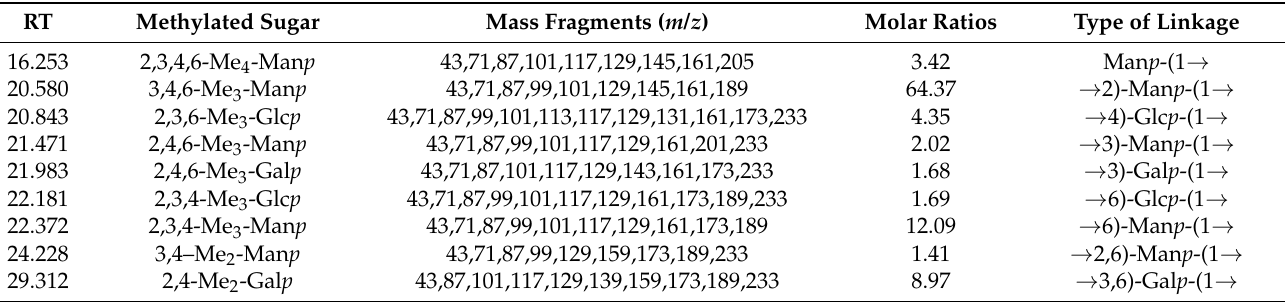
Table 2. Results of methylation